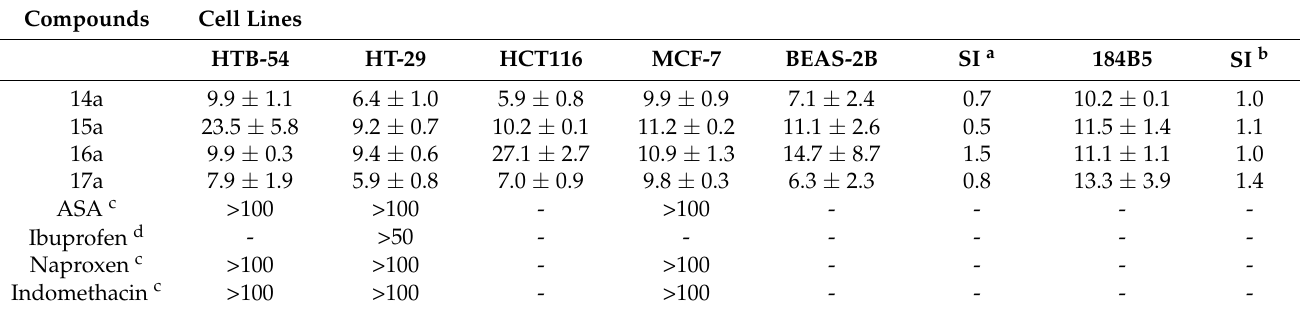
Table 3. IC 50 values (in µ M) for compounds, 14a – 17a , and the parent NSAIDs in HTB-54, HT-29, HCT116, MCF-7, BEAS-2B and 184B5 cell lines, and selectivity